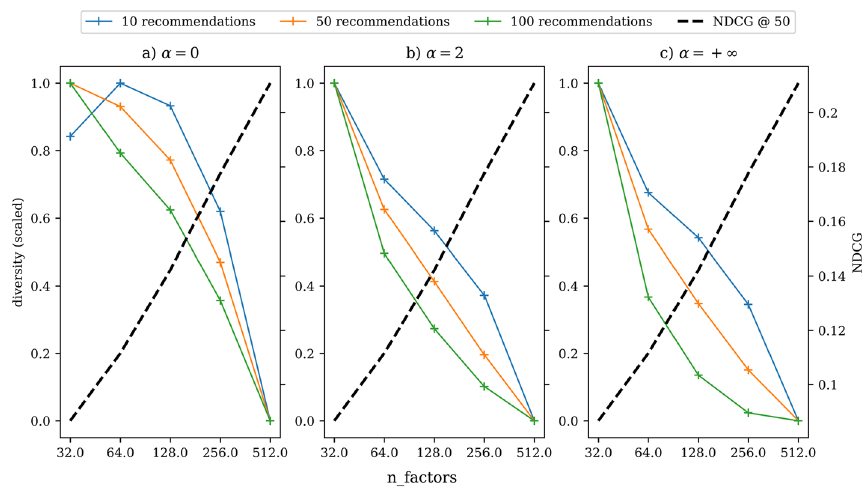
Fig. 4 Diversity (normalized) and performance of the